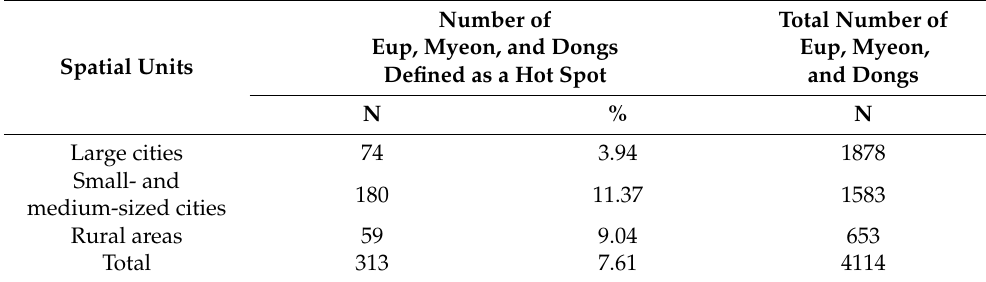
Table 8. Number of Eup, Myeon, and Dongs defined as a hot spot in large cities and small- and medium-sized cities.